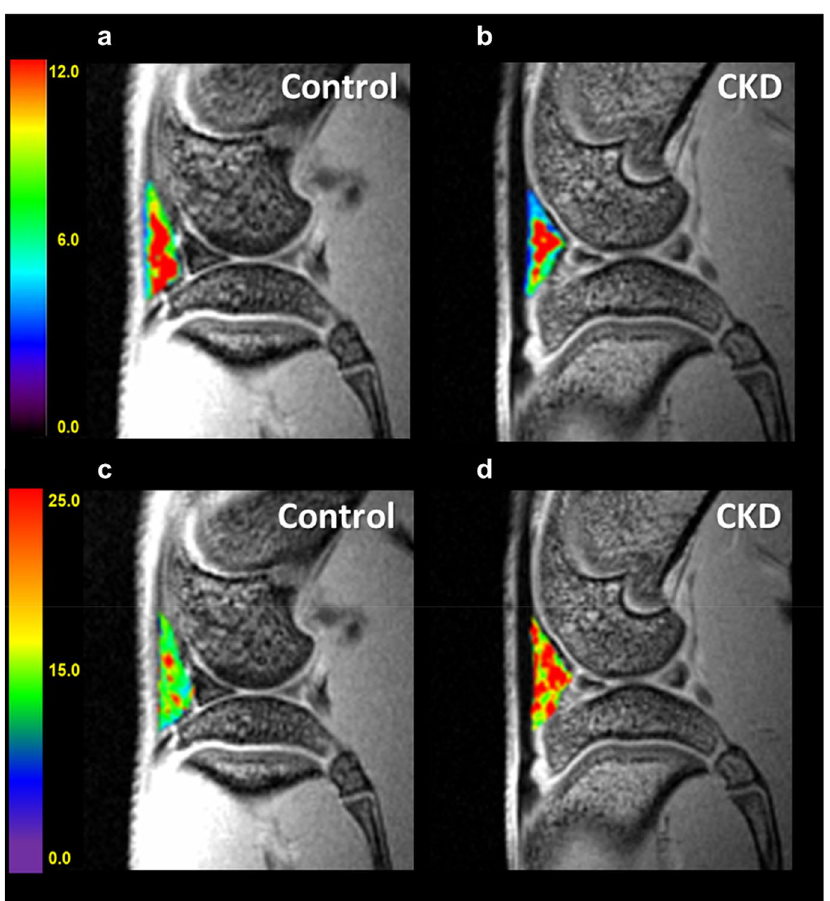
Figure 2. The demonstrated perfusion parameter A and MRI T2* maps of infrapatellar fat pad in control and CKD rats. The DCE-MRI (amplitude A ) maps of infrapatellar fat pad in both groups. The color-coded images show significant hypo-perfusion in the CKD group ( b ) as compared to the control group ( a ), especially in the outer margin. Compared to the control group ( c ), the CKD group ( d ) had significantly higher T2* values ( p <